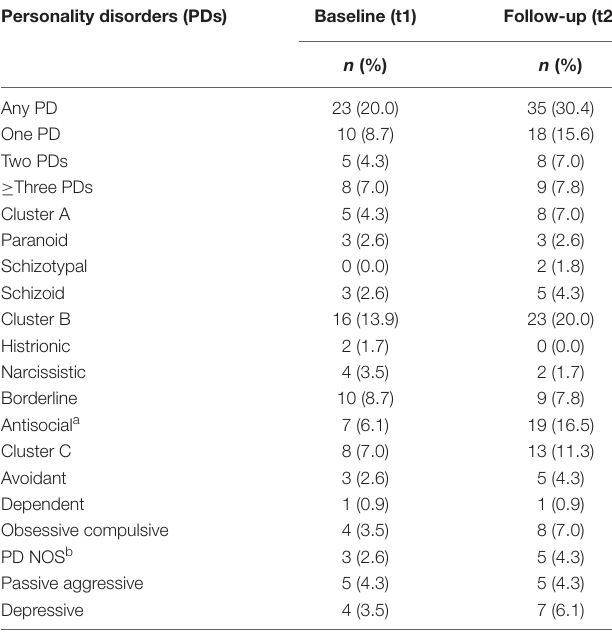
TABLE 3 | Prevalence rates of personality disorder diagnoses at baseline (t1) and follow-up (t2) ( N = 115). Personality disorders